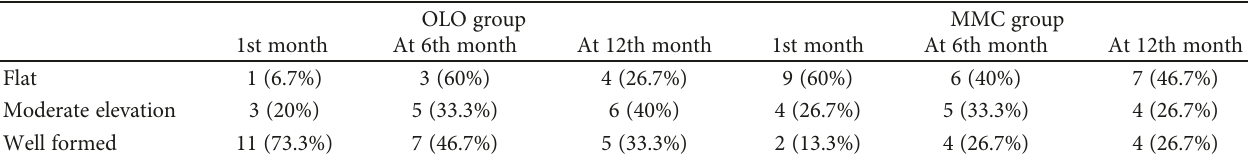
Table 2: Bleb height during follow-up in both